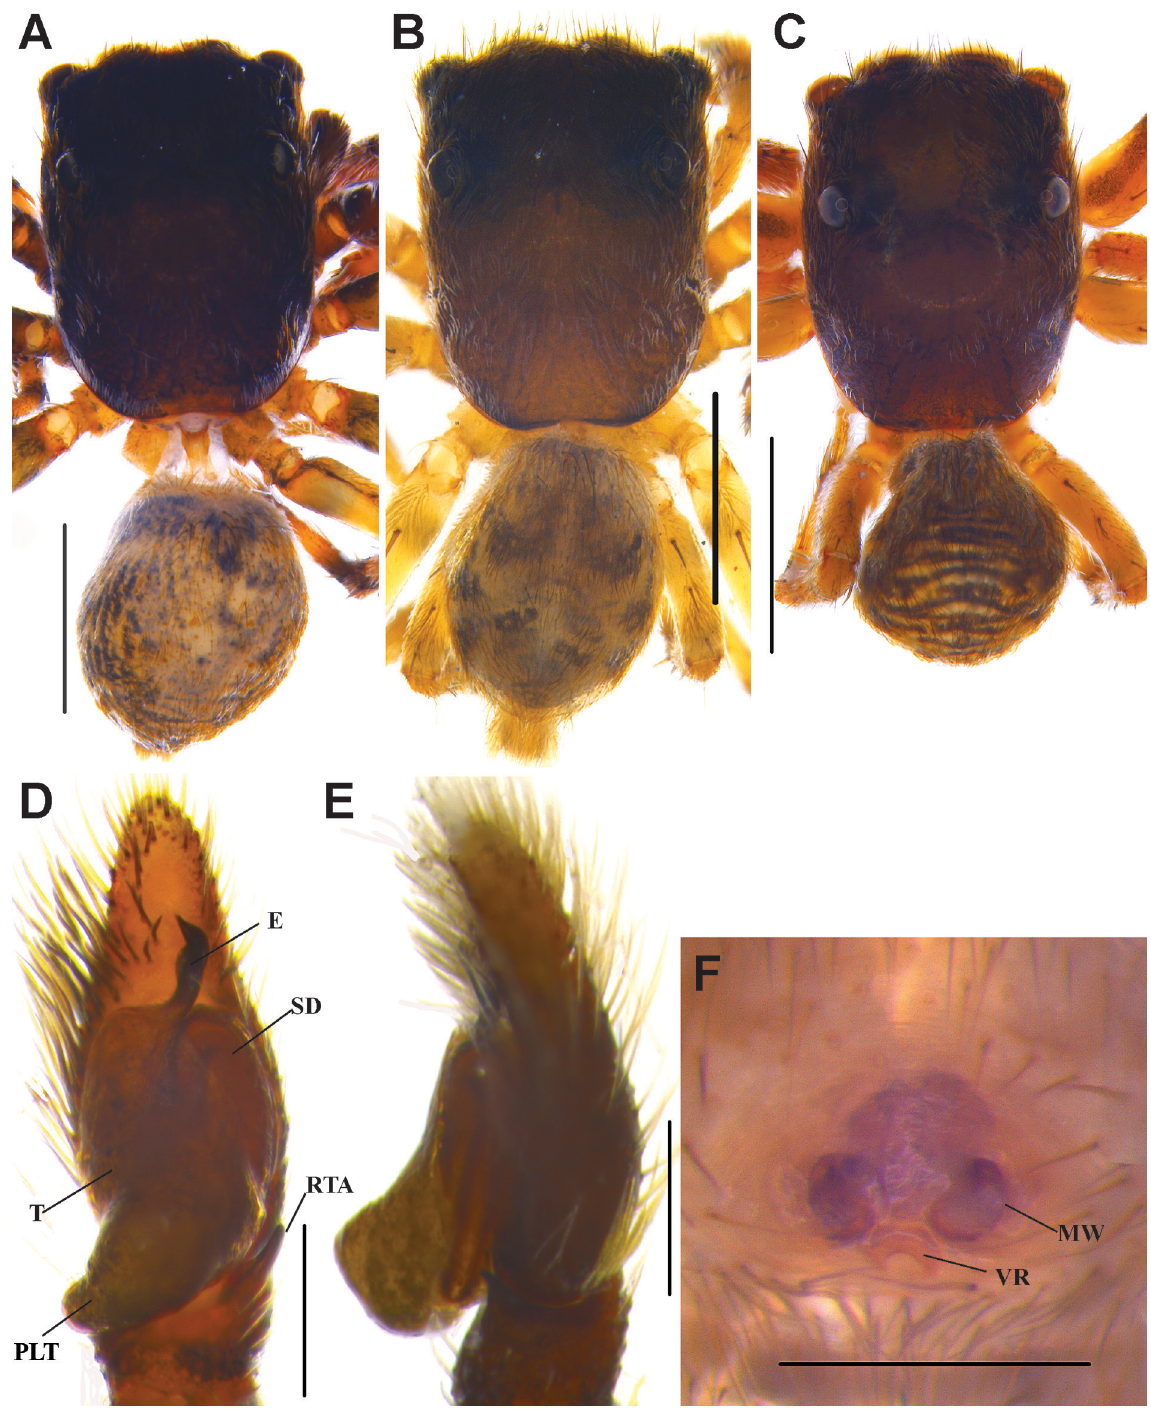
Fig. 7. Habrocestum kodigalaensis sp. nov. A . Habitus, ♂ from Ritigala SNR, Kodigala, dorsal view (IFS_SAL 516). B . Habitus, ♂ from Riverston, Knuckles, dorsal view (IFS_SAL 345). C . Habitus, ♀ from Ritigala SNR, Kodigala, dorsal view (IFS_SAL 467). D . Male palp, ventral view. E . male palp, retrolateral view. F . Female epigynum, ventral view. Abbreviations: E = embolus; MW = membranous window; SD = sperm duct; T = tegulum; PLT = proximal lobe of tegulum; RTA = retrolateral tibial apophysis; VR = vaginal roof. Scale bars: A–C = 1 mm; D–F = 0.2